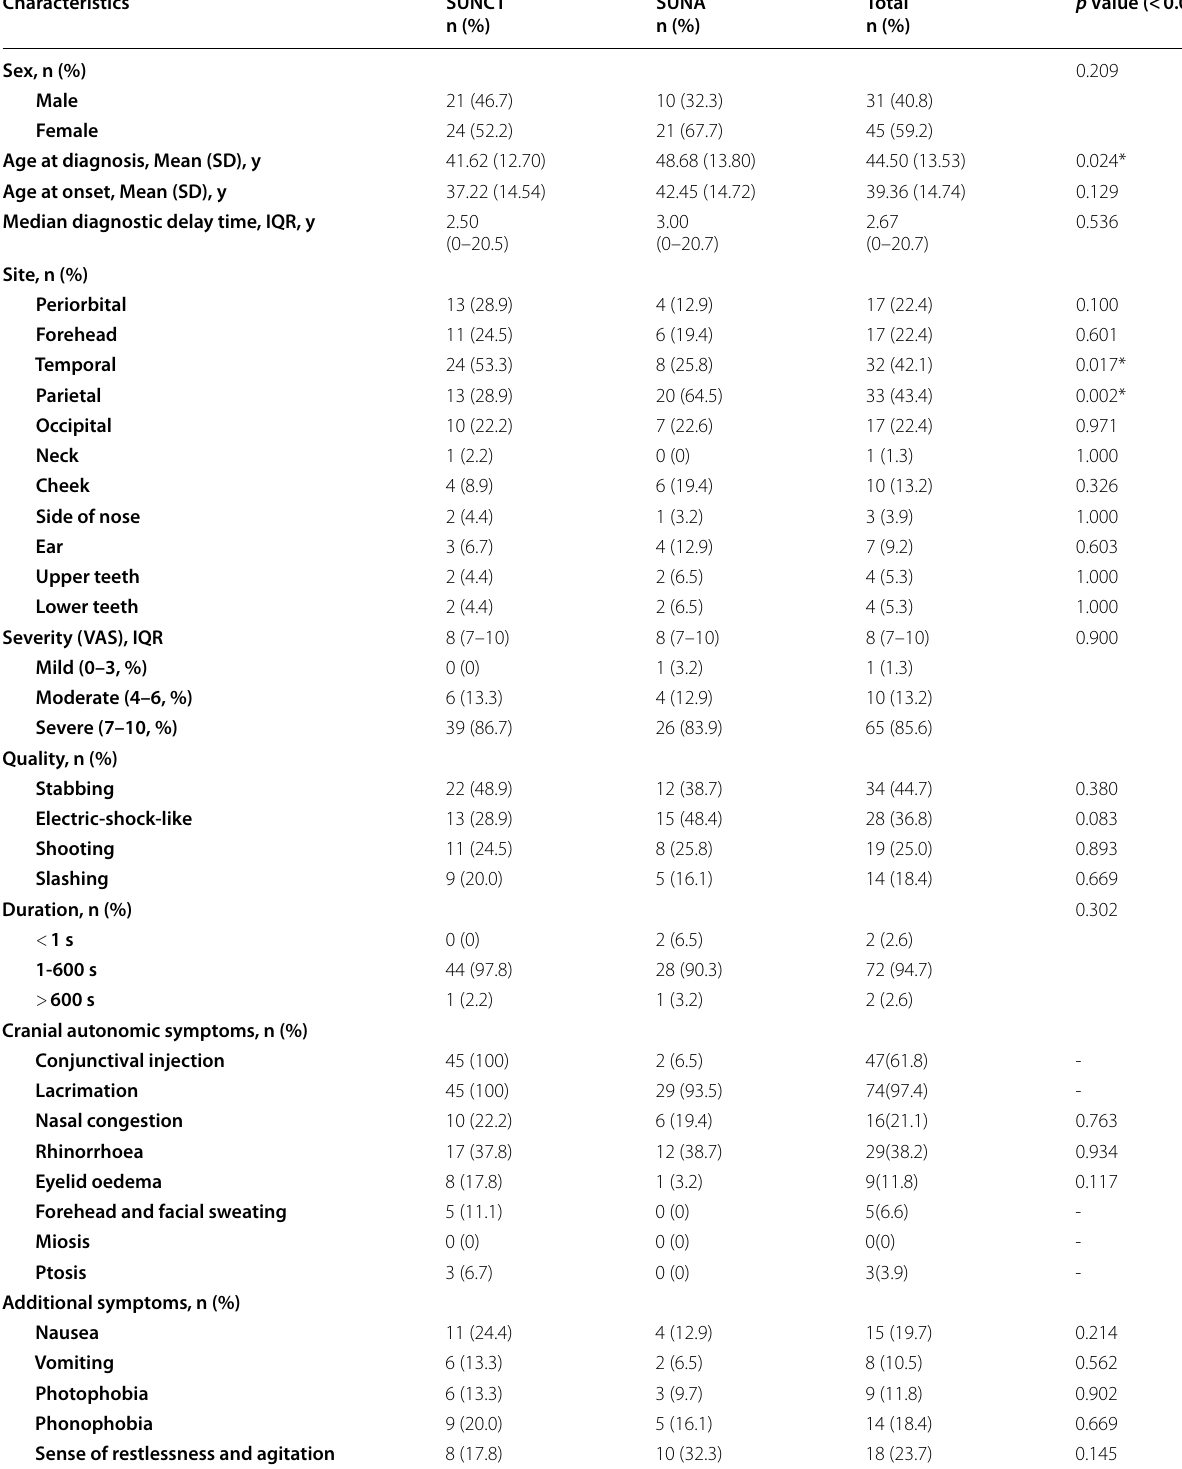
Table 1 Demographics and clinical characteristics of the study participants ( n